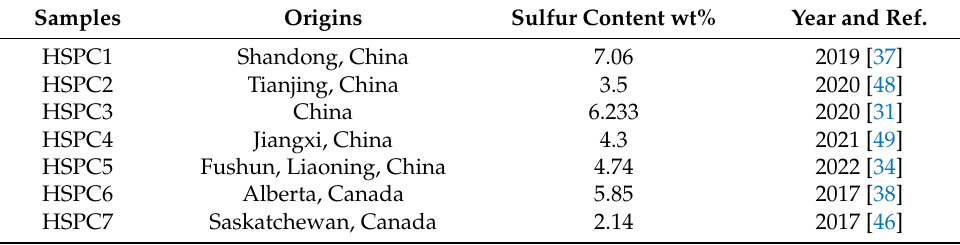
Table 1. The total sulfur content of HSPC samples selected from different origins.